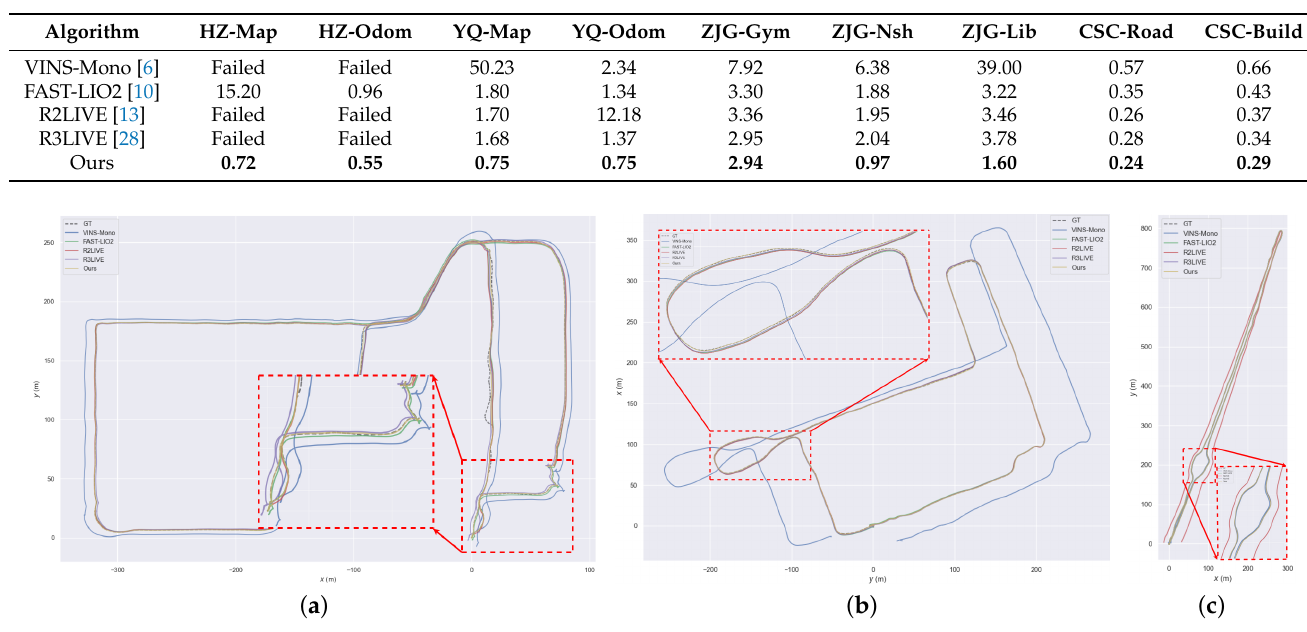
Figure 13. ( a ) The trajectory results on ZJG-nsh dataset. ( b ) The trajectory results on YQ-map dataset. ( c ) The trajectory results on YQ-odom